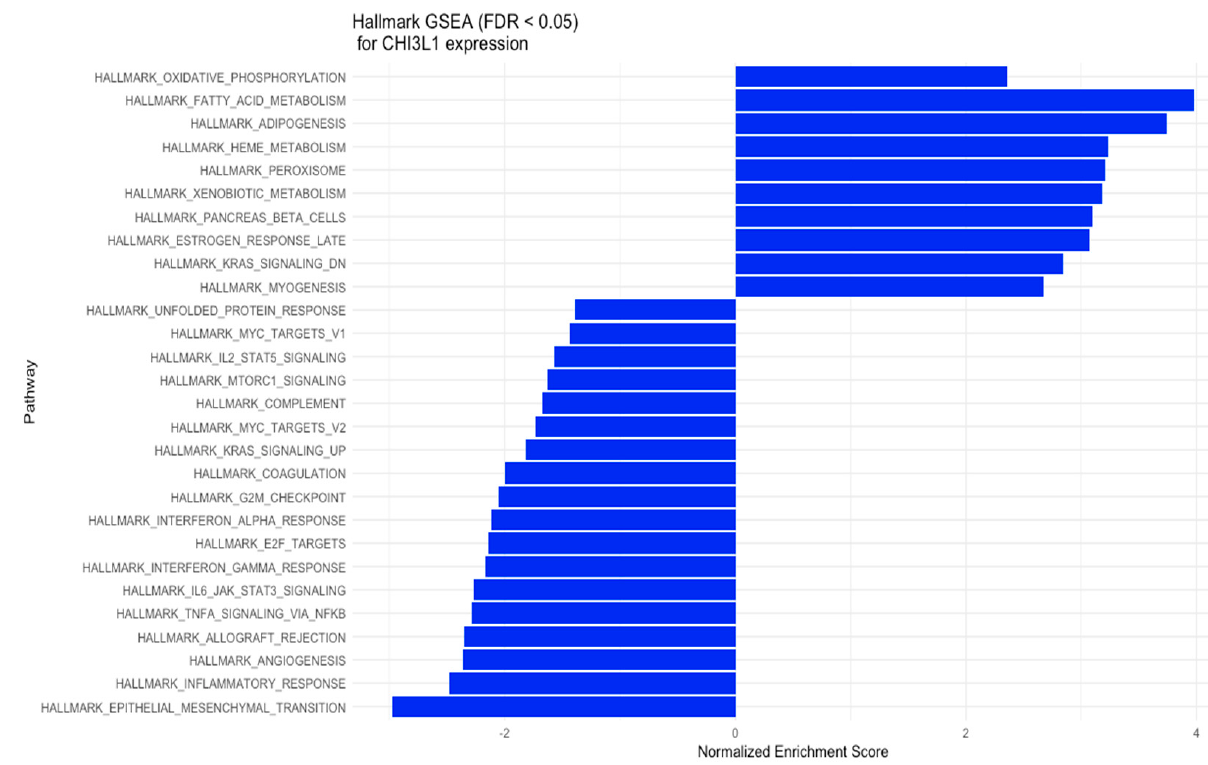
Figure 3. GSEA for the expression of YKL-40 (CHI3L1) in various hallmark gene sets. 3.3. Exploration of Immunogenicty and the Immune Infiltration Landscape of YKL-40 Based on TCGA-COAD Data The immune scores of intratumor heterogeneity, macrophage regulation, lymphocyte infiltration signature score, IFN-gamma response, Th1 cells, and TGF-beta response